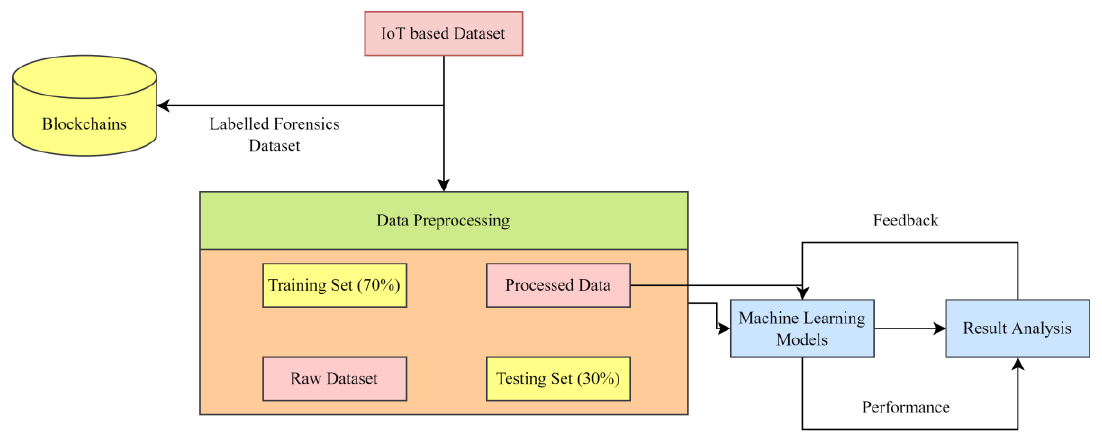
Figure 1. Proposed Framework